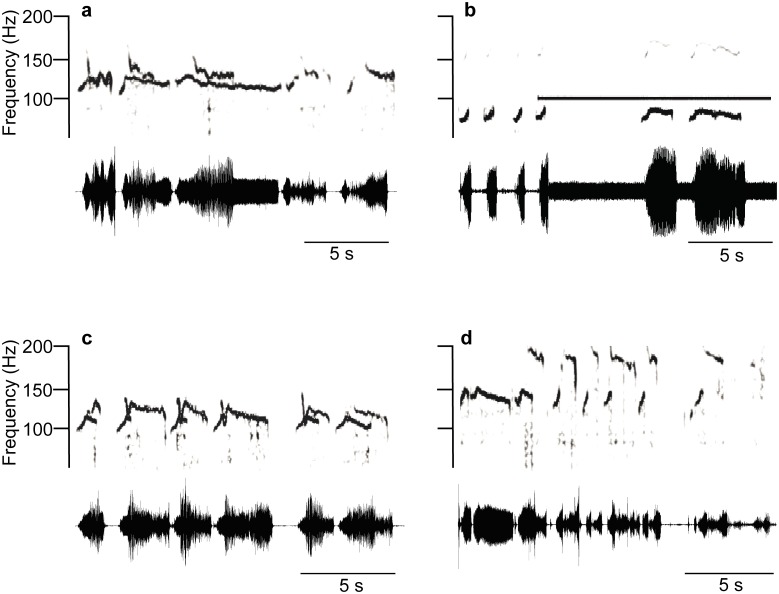
Changes of overlapped Eushistus heros FS-1 and MS-1 pulse time and frequency characteristics.Sonograms (above) and oscillograms (below) of (a) increased FS-1 pulse duration when overlapped by MS-1 signals or (b) by 100 Hz/0.69 mm/s pure tone. c: the U-shaped FM sweep of MS-1 pulses masked by FS-1 signals. d: the increased frequency and decreased duration of MS-1 pulses in a duet with FS-1 signals.